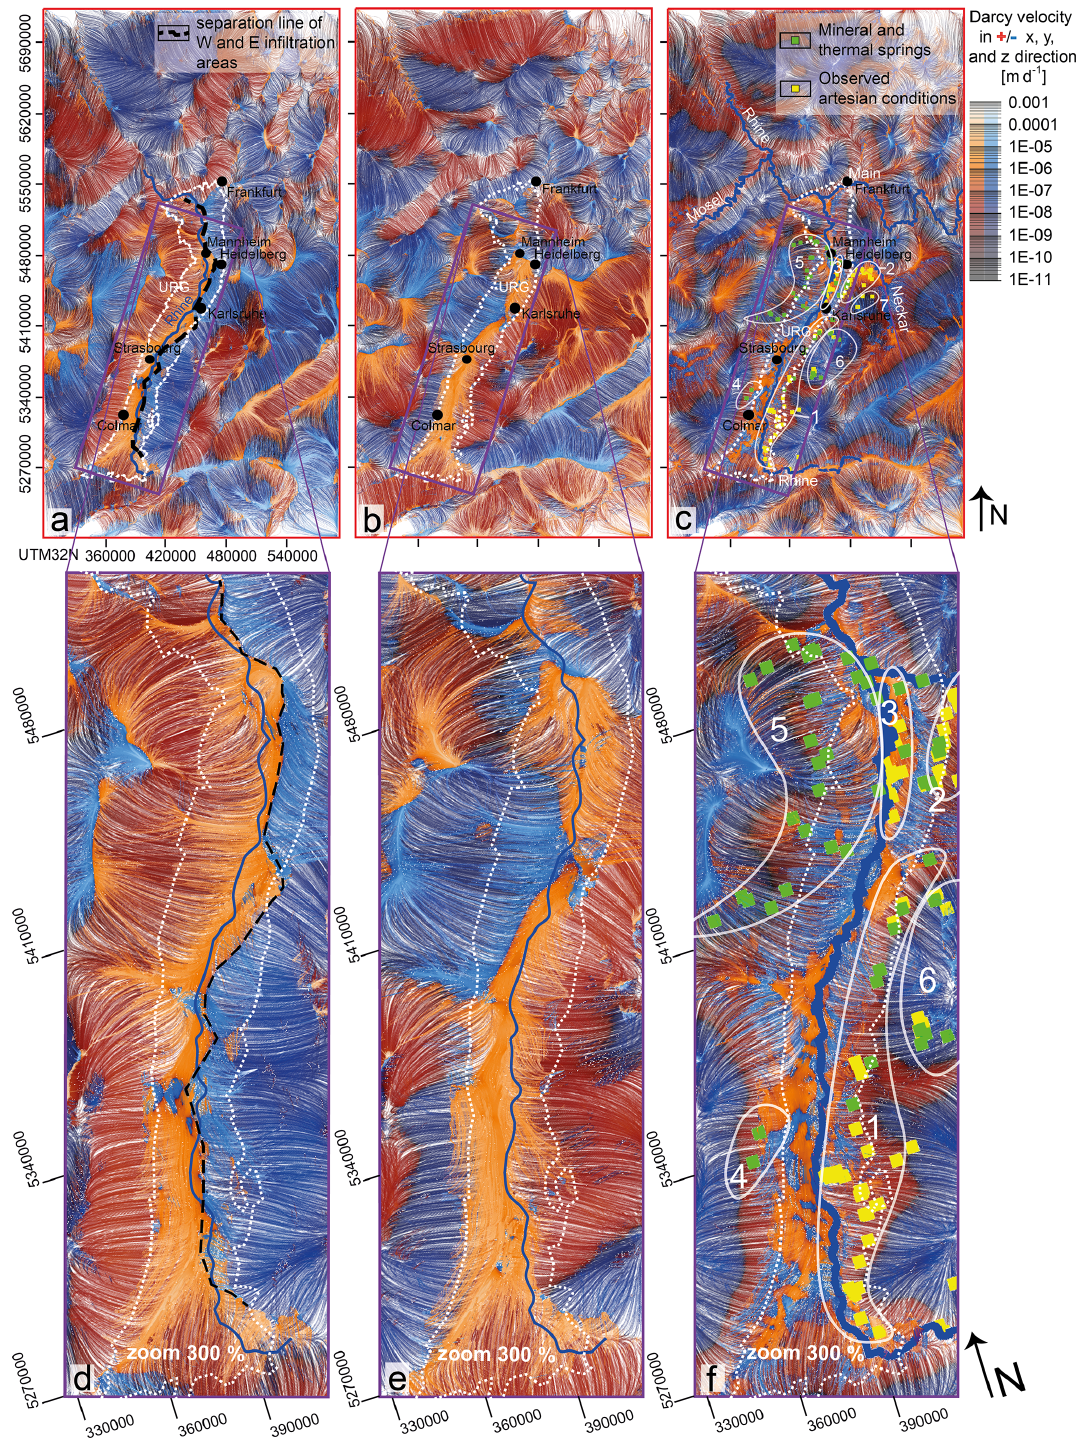
Figure 5. Streamlines of simulated fluid flow with different colors for the x , y , and z component of the flow vector. (a) The west–east ( x ) component, (b) north–south ( y ) component, and (c) vertical ( z ) component of the flow vector. In orange is the positive (east, north, and ascending) component and in blue is the negative (west, south, and descending) component of the flow vector in Darcy velocities, calculated with ParaView’s stream tracer filter for the entire model domain (Squillacote et al., 2007). In green are the mineral and thermal springs from BRGM (2016), LGB (2002), and LGRB (2006). In yellow are the artesian springs from LGRB (2015). The data on artesian conditions are only available for the eastern side of the Rhine. The white dotted line reflects the outline of the sediments of the